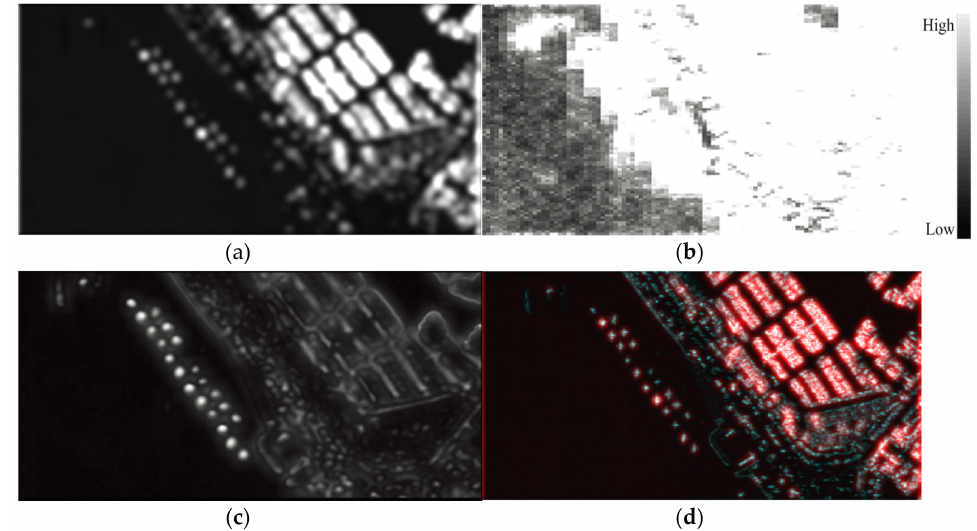
Figure 11. Saliency map generation results of the UAVSAR L-band data with complex image scenes. ( a ) The proposed method; ( b ) The SDPolSAR method; ( c ) The PRSaliency method; ( d ) Span image overlaid with the saliency map of ( a ), where the red regions are